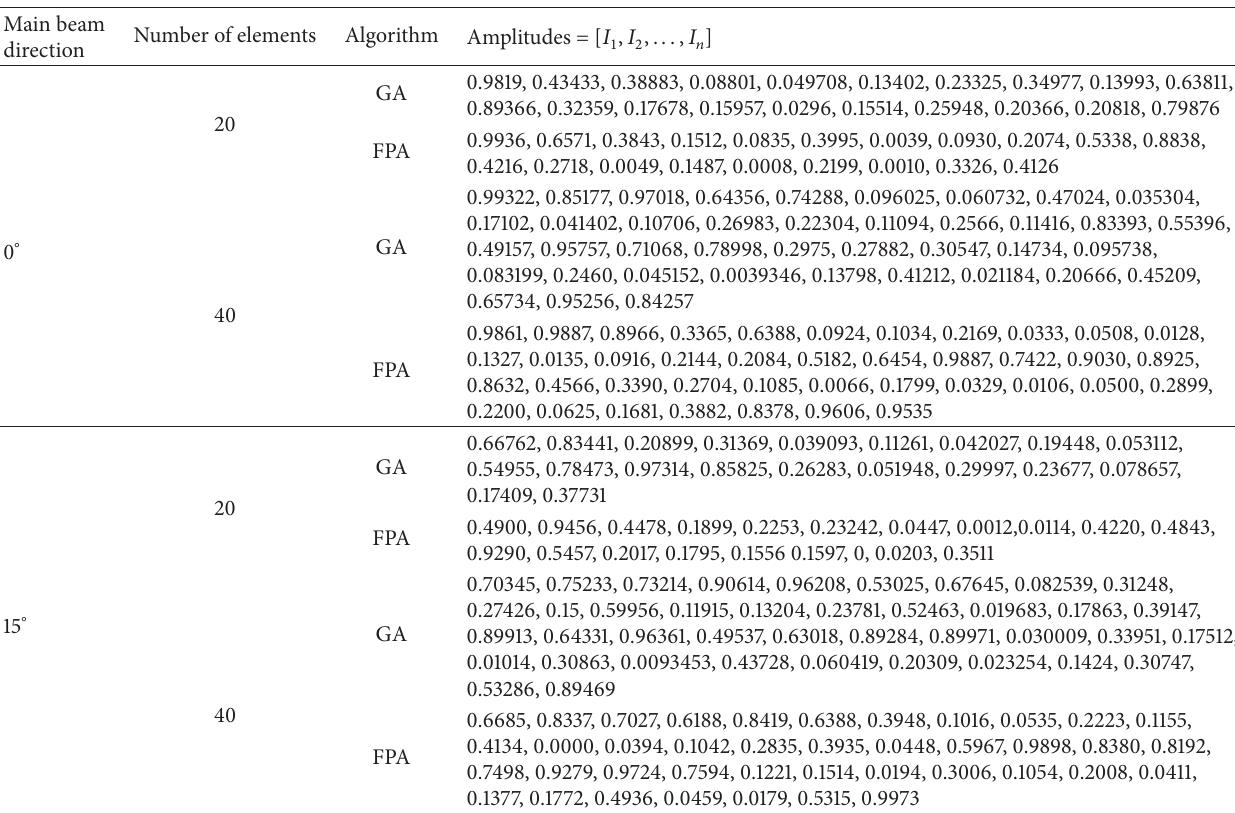
Table 1: Amplitude distribution for Cases 1 and 2.